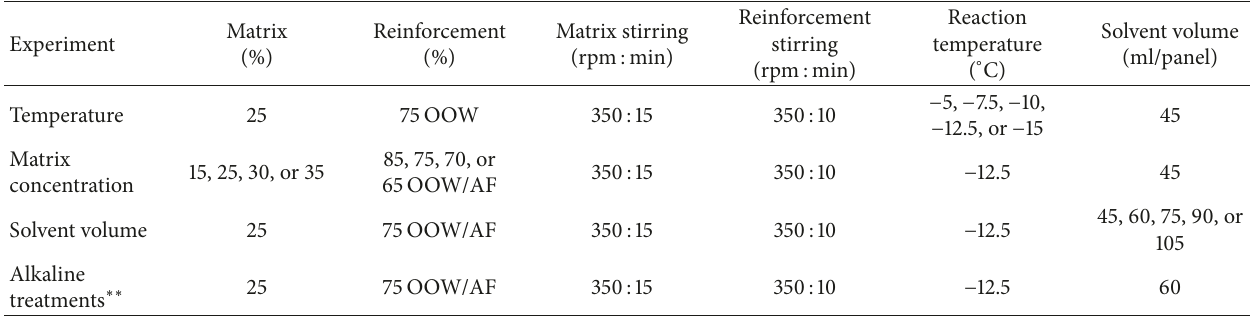
Table 2: Parameters for experiments conducted ∗